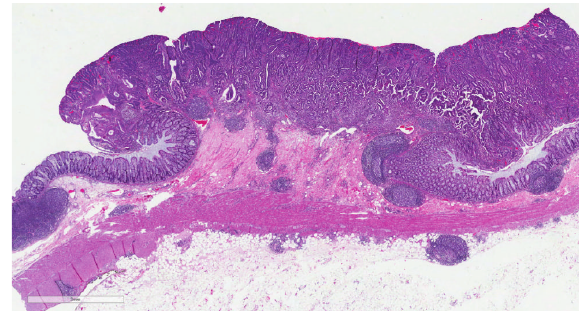
Figure 4: Histological examination (hematoxylin-eosin staining; magnification 3x) of the resected large bowel specimen showing a moderately differentiated adenocarcinoma invading into the